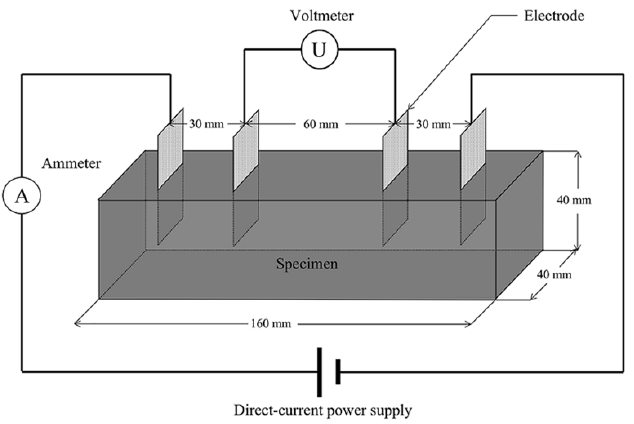
Figure 1. Specimen and electrode configuration.